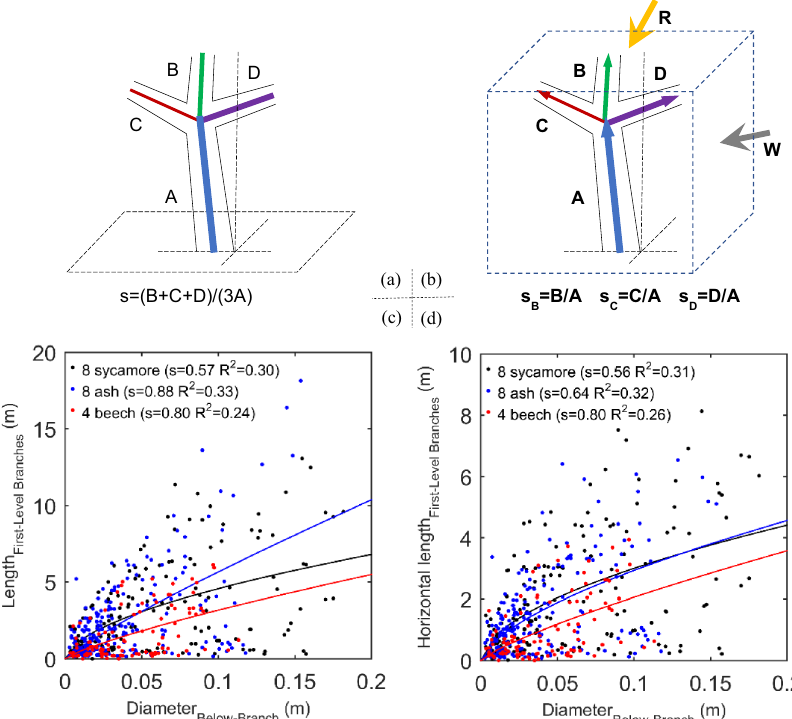
Fig. 2 The 3D mode transition for reexamining the basic theories of plant forms. Illustration of the potential of proposing 3D allometric scaling for plants, via comparing, in principle, the effects of the ( a ) scalar — (length: A, B, C, and D) and ( b ) vector-parameter-based (length and orientation: A, B, C, and D) allometric scaling (s and s) characterizations that are based on the traditional and 3D-mode plant mapping technologies, respectively. The latter can open a new way for 3D upgrading the traditional allometric theory to adapt to the ecological analyses with the, in essence, vector-mode environmental forces such as solar radiance 55 (R) and wind fi elds 56 (W). Enabled by the proposed 3D theoretical framework, we found that the diameters of the trunk below branches are more correlated with the horizontal components of the fi rst-level branches than themselves ( c ) vs. ( d ), for the samples of Sycamore ( Acer pseudoplatanus , 180 fi rst-level branches for all of its trees) and Beech ( Fagus sylvatica , 104) tree species in the Wytham Woods, UK 52 , as characterized by a comparison of the performance in terms of R 2